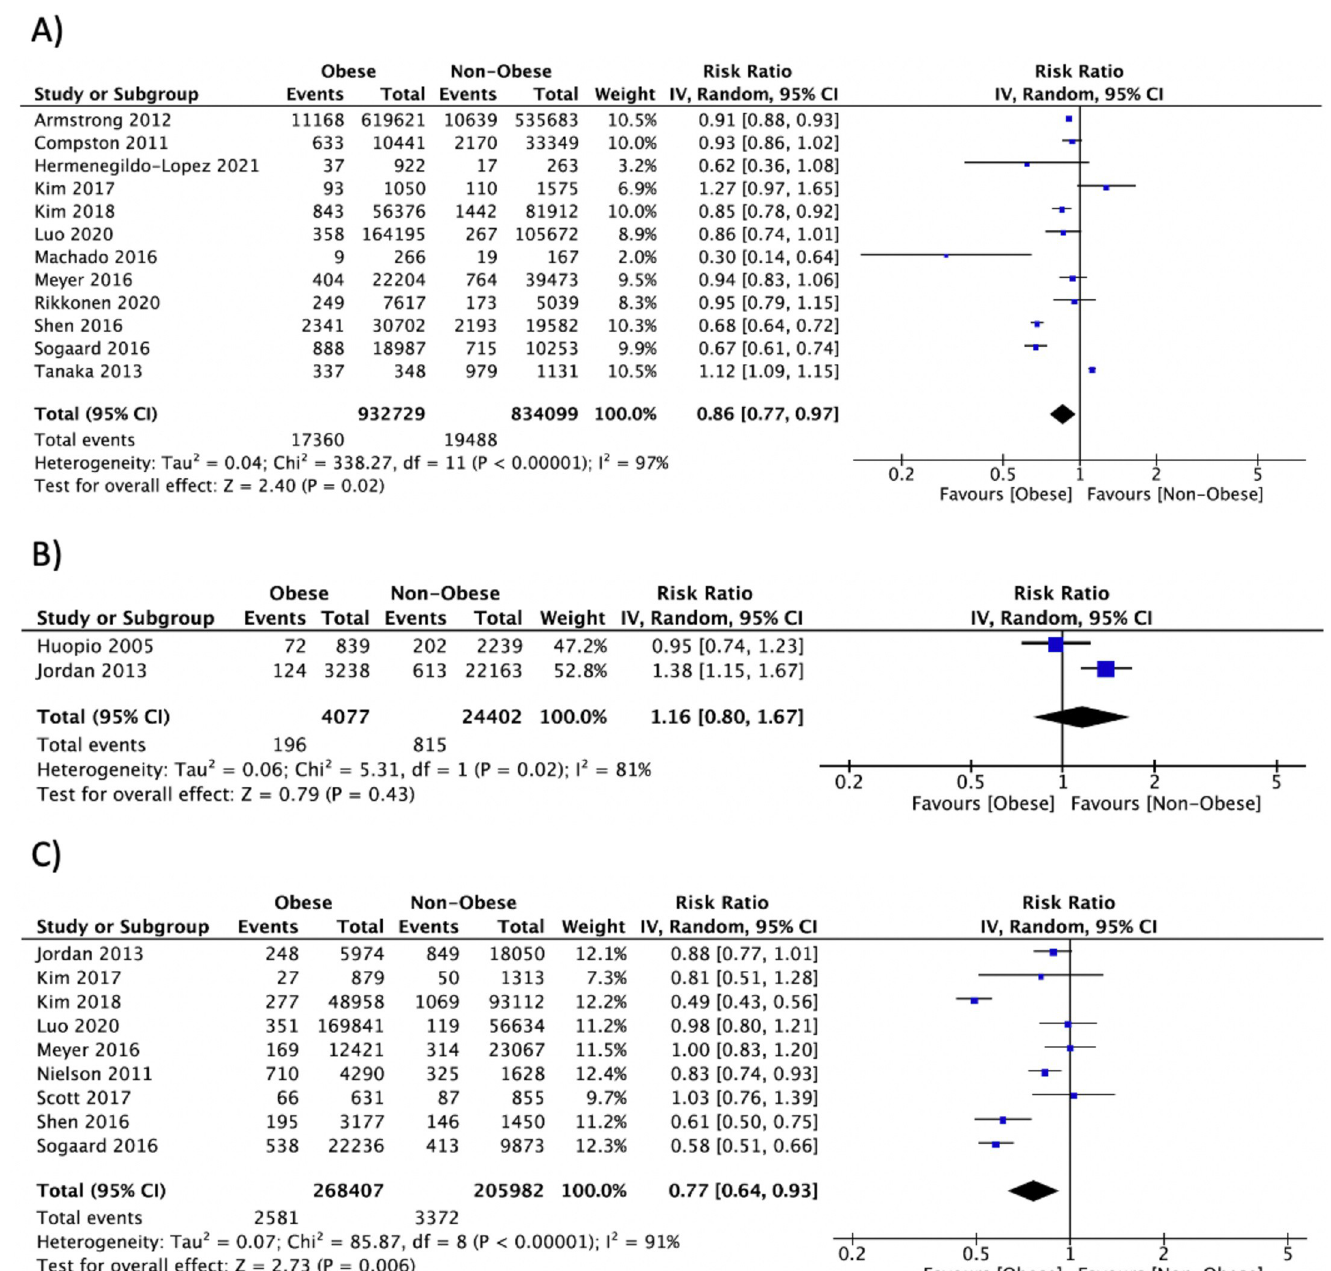
Fig 2. Forest plot of pooled effect size for the risk of fracture at any site in A) postmenopausal women, B) premenopausal women, and C) men with vs. without obesity, using a random-effect model. https://doi.org/10.1371/journal.pone.0252487.g002 and men (n = 9: RR = 0.77, 95% CI: 0.64, 0.93, P = 0.006, I 2 = 91%). No association between obesity and risk of fracture at any site in premenopausal women was found (n = 2: RR = 1.16, 95% CI: 0.80, 1.67, P = 0.43, I 2 = 81%) ( Fig 2 ). Moreover, there was no association between obe- sity and risk of fracture in studies combining men and women (n = 4: RR = 0.97, 95% CI: 0.72, 1.31, P = 0.84, I 2 = 96%). Subgroup analyses did not explain the heterogeneity within groups.